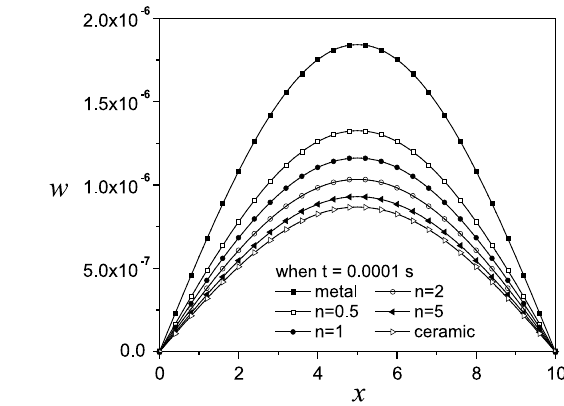
Fig. 19. Deflection of the mid-plane for the simply supported FGPM cylindrical shell imposed by a sinusoidal distributed load, when t = 0 . 001